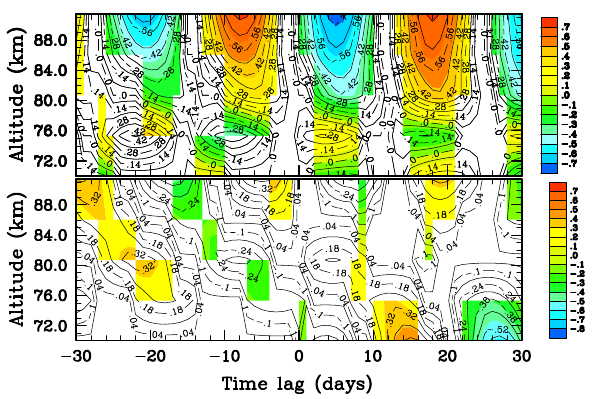
Fig. 7. The same as Fig. 5, but for H 2 O.